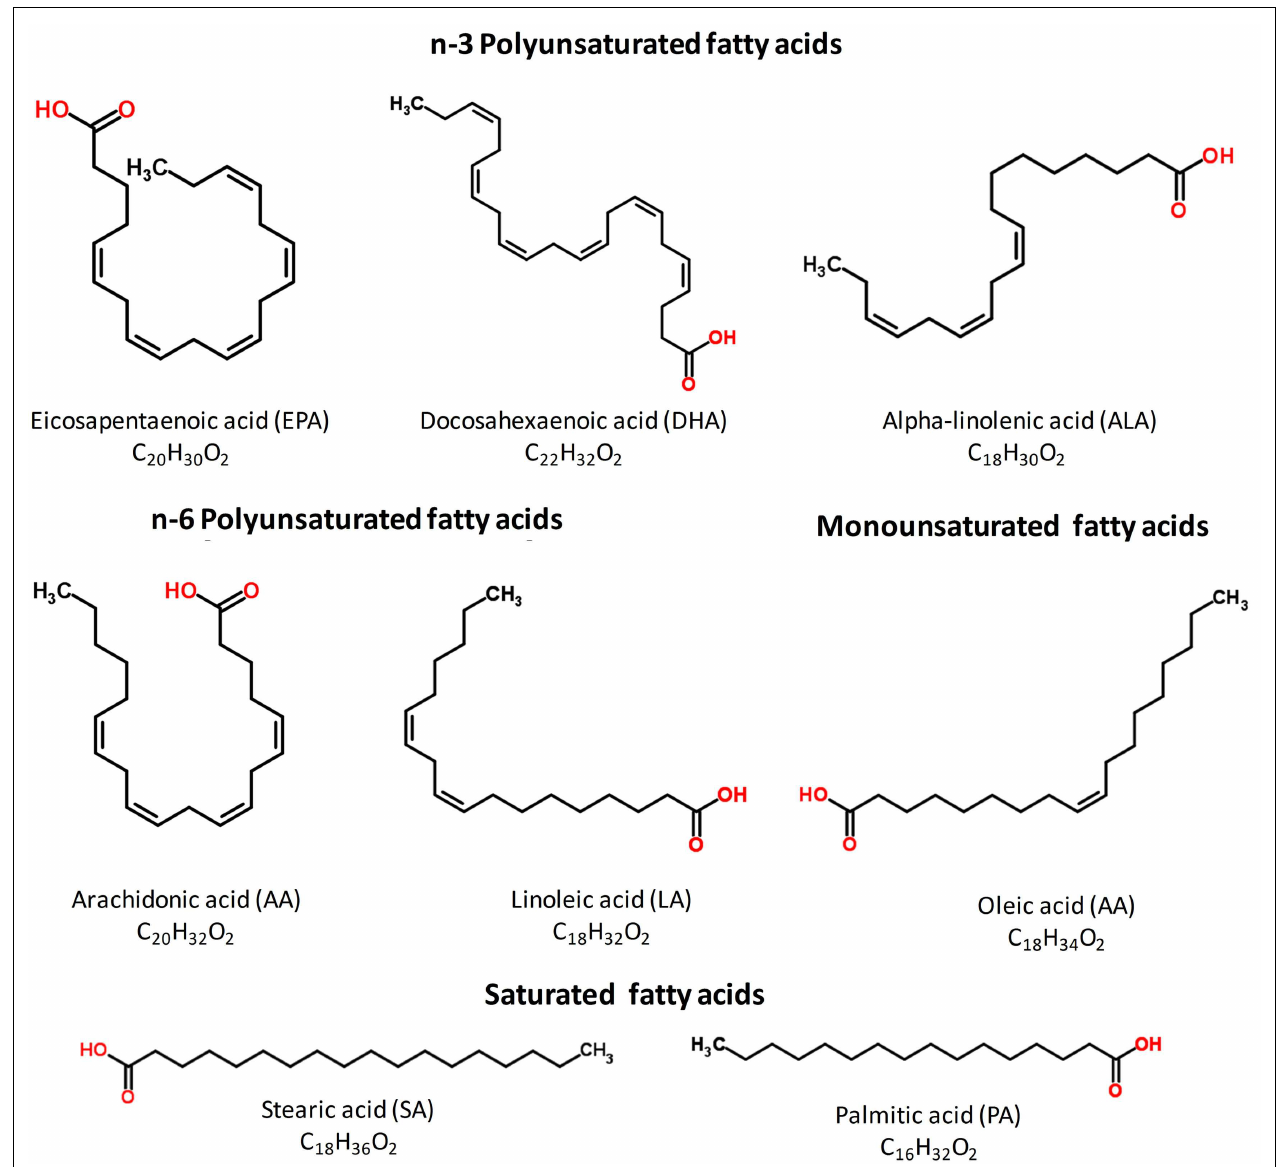
FIGURE 1 | Structure of the main n − 3 (EPA, DHA, andALA), n − 6 (AA and LA), monounsaturated (OA), and saturated (SA and PA) PUFAs present in the human diet. Taken from the free ChemSpider Database